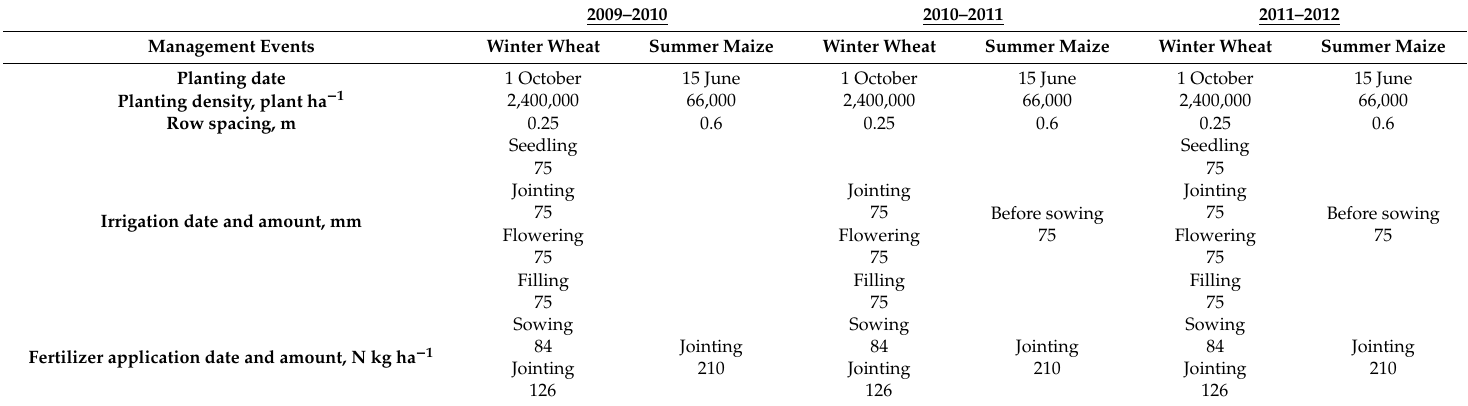
Table A2. Summary of crop management practices conducted for the experiment during 2009 to 2012